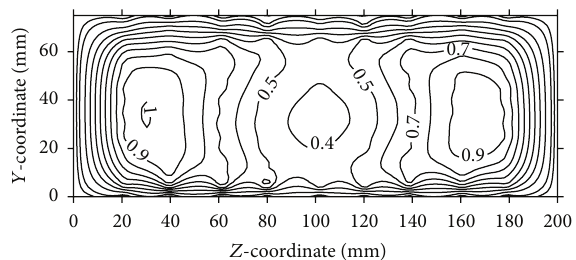
Figure 8: Normalized velocity contours at the outlet plane of bare air-intake.